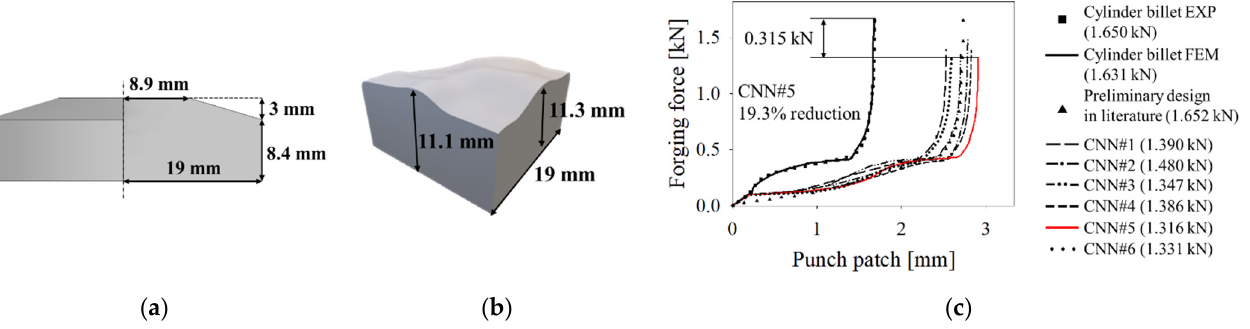
Figure 16. ( a ) The preform design from the literature [26], ( b ) preform design by CNN#5, and ( c ) experimental forging force–punch patch curves from the literature from FEM for the designed preforms by CNN sub-models.